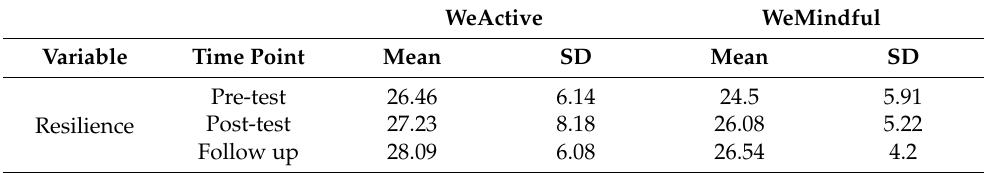
Table 6. Descriptive statistics of resilience by group at pre-test, post-test, and follow up.